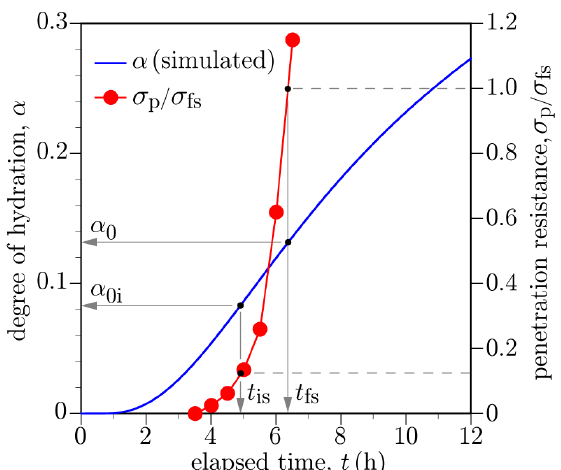
Figure 15. Determination of degrees of hydration at initial and final sets using recorded penetration resistance data